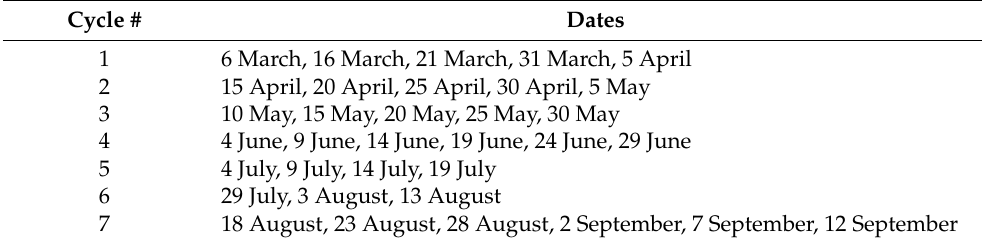
Table A1. Sentinel-2 imagery (for 2021) utilized in this study.